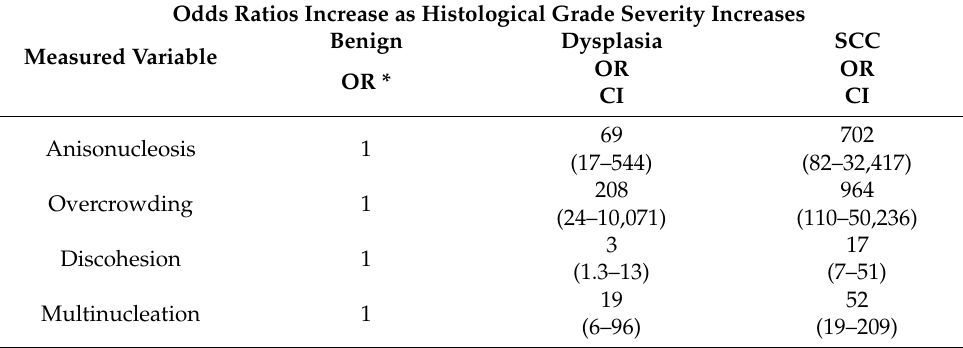
Table 2. Odds ratios (ORs), a measure of association between the histopathological grading and the assessed variables, were calculated in each instance. Benign grading was used as a reference group. Sites graded as dysplastic had increased odds compared to benign in every instance. SCC had the greatest odds ratios compared to dysplasia and benign. It is noted that this is a sparse dataset with confidence intervals showing a wide range of